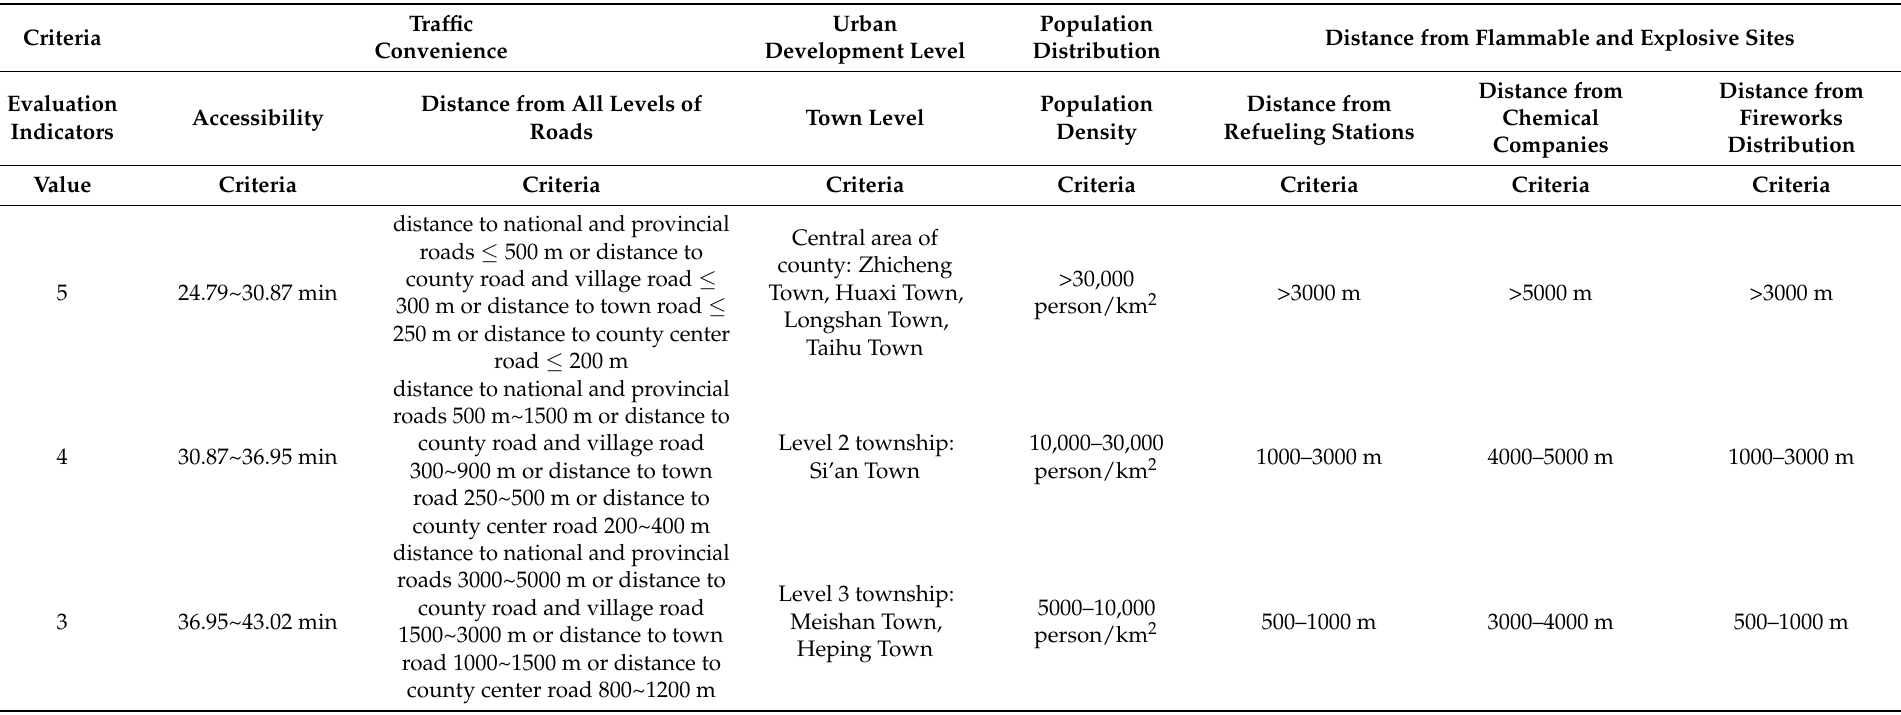
Table A1. Evaluation criteria and results of influencing